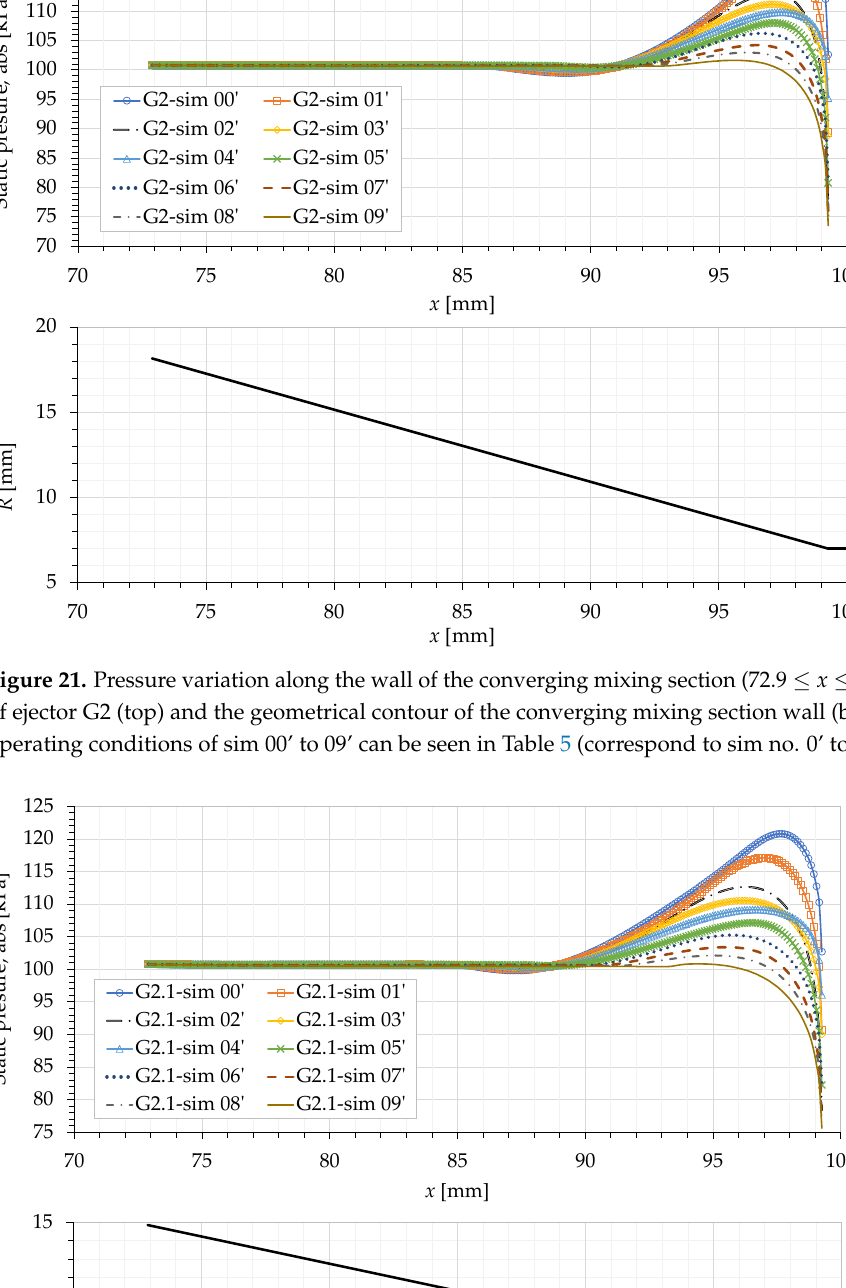
Figure 23. Streamlines plot (colored by pressure) started from the secondary flow inlet for ejector G2 with operating condition of simulation no. 0’ (Table 5), i.e., 𝑃 (cid:2868) = 618 kPa. Regarding the “anomaly” of simulation no. 4’ (sim 04’), it is related to the shock cells position and size inside the ejector, particularly in this case, inside the converging mixing section. Looking at sim 04’ in Figure 24, one can see that the end of one of the shock cells is located just before the ET inlet. Thus, the hypothetical annular duct formed is diverging. This will hinder the flow to accelerate. The decrease in the flow acceleration shows up in the pressure curve of sim 04’ as a less steep pressure drop after the peak. Observing the Mach contour plot of the other simulations in this figure, it is clearly seen that the hypothetical annular duct near the ET inlet is converging and, therefore, the pressure drop in the curve is steeper because the flow has higher acceleration.